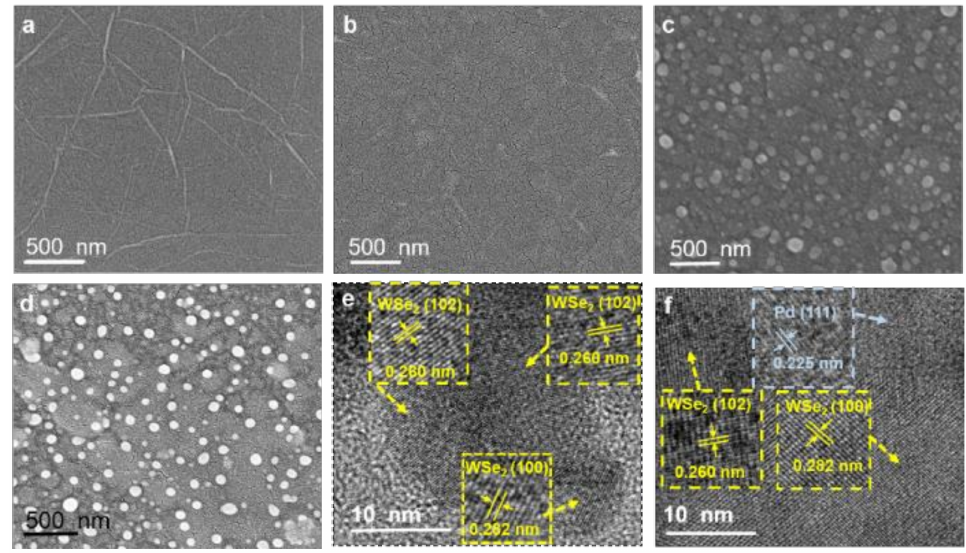
Figure 3. SEM images of the self-assembled ( a ) rGO, ( b ) rGO/WSe 2 , ( c ) rGO/Pd, and ( d ) rGO/WSe 2 /Pd, high-resolution TEM images of ( e ) rGO/WSe 2 and ( f ) rGO/WSe 2